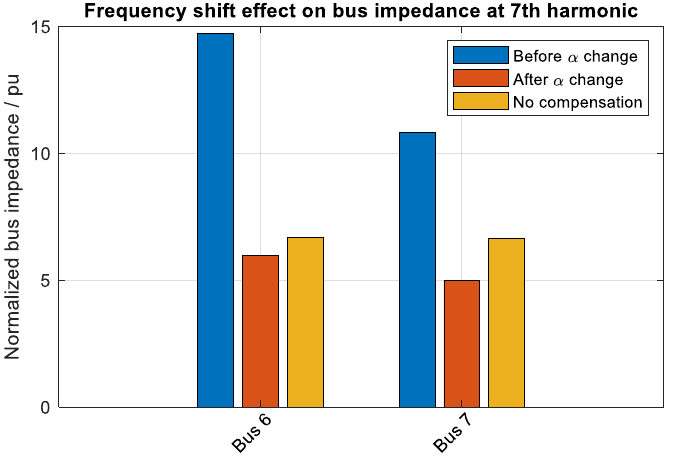
frequency Figure 10. Comparison of the impedances of busses 6 and 7 before and after the parallel frequency shift.